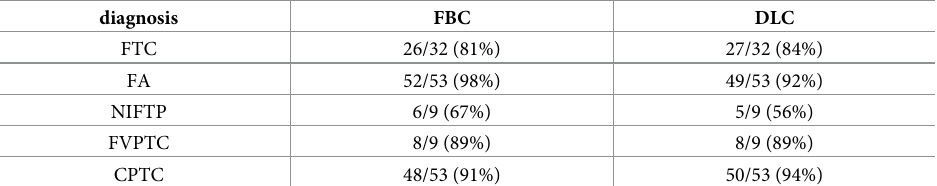
Table 1. Number of correct predictions relative to the amount of samples split into the diagnostic groups of the initial dataset. Results are shown for the feature-based classification (FBC) and deep learning-based classification